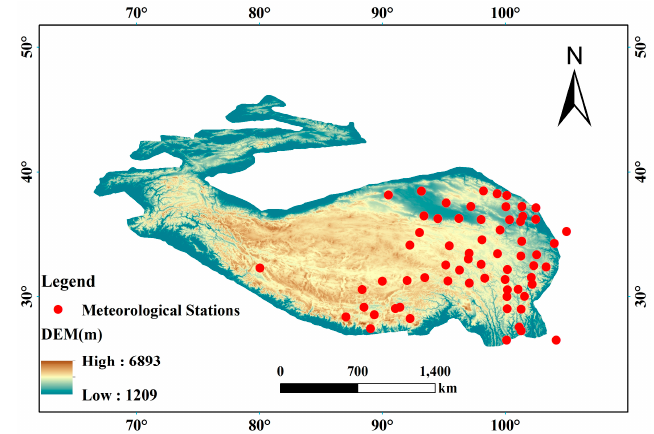
Figure 1. The location of selected meteorological stations. Table 1. Detailed information of the selected stations.